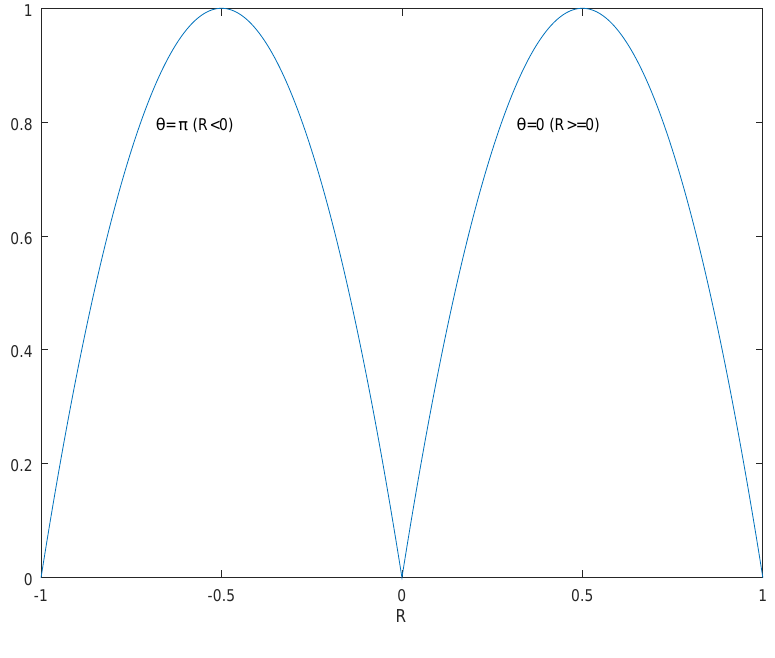
Figure 2. Vertical section of Figure